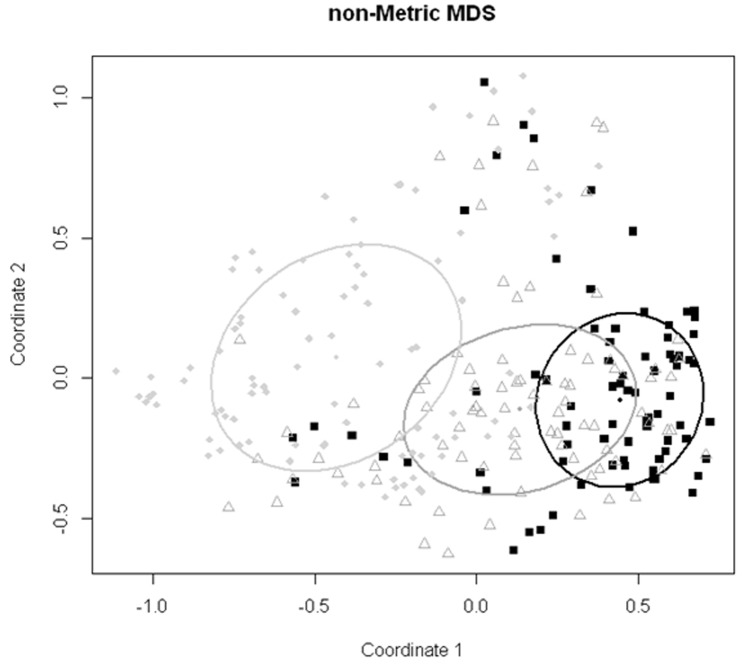
Non-metric multi-dimensional scaling ordination plot of the distance between bacterial communities based on the Bray-Curtis distance.The ellipses represent the samples which were within 75% confidence limit of the centroids and included the wet bank (circles), dry bank (triangles) and the terrestrial samples (squares) (Stress = 0.12).